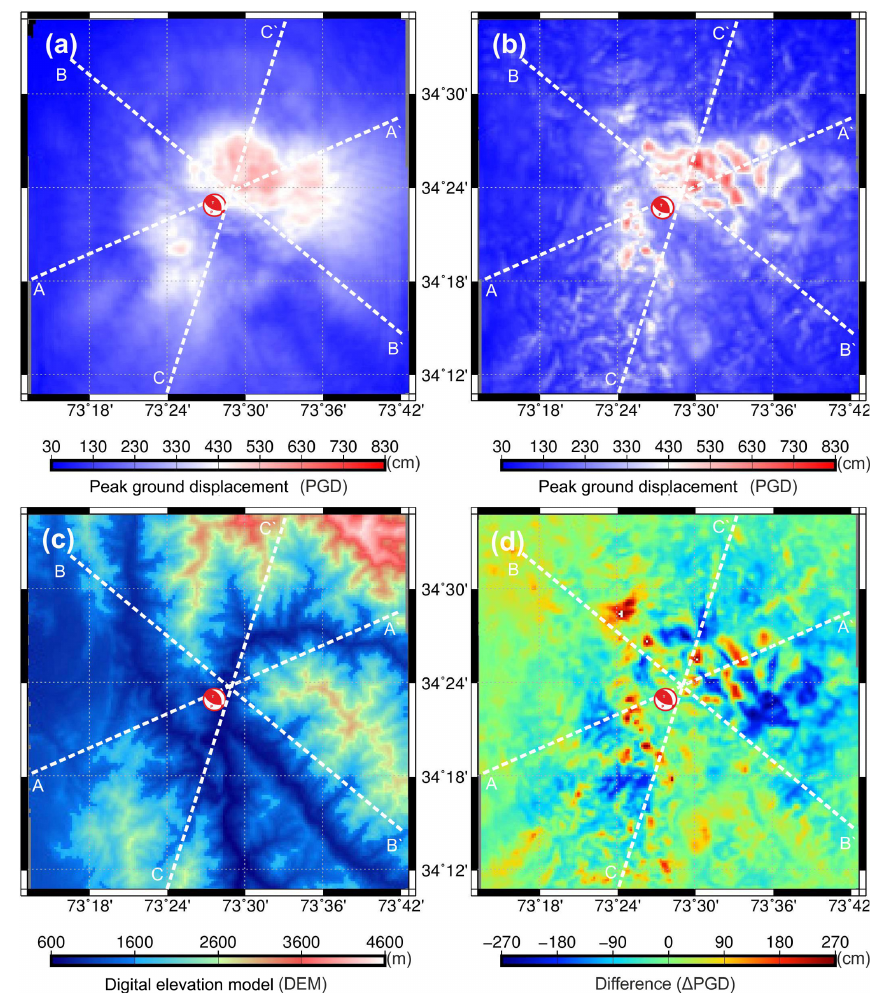
Figure 4. (a) Peak ground displacement (PGD) for the model without topography, (b) PGD for the model with topography, (c) topography (ASTER Global DEM at 270m), (d) difference between panels (a) and (b) ( (cid:49) PGD). Red colors (positive values) indicate amplification, blue (negative values) indicate de-amplification while green represents zero difference. The CMT location is represent by a red beach